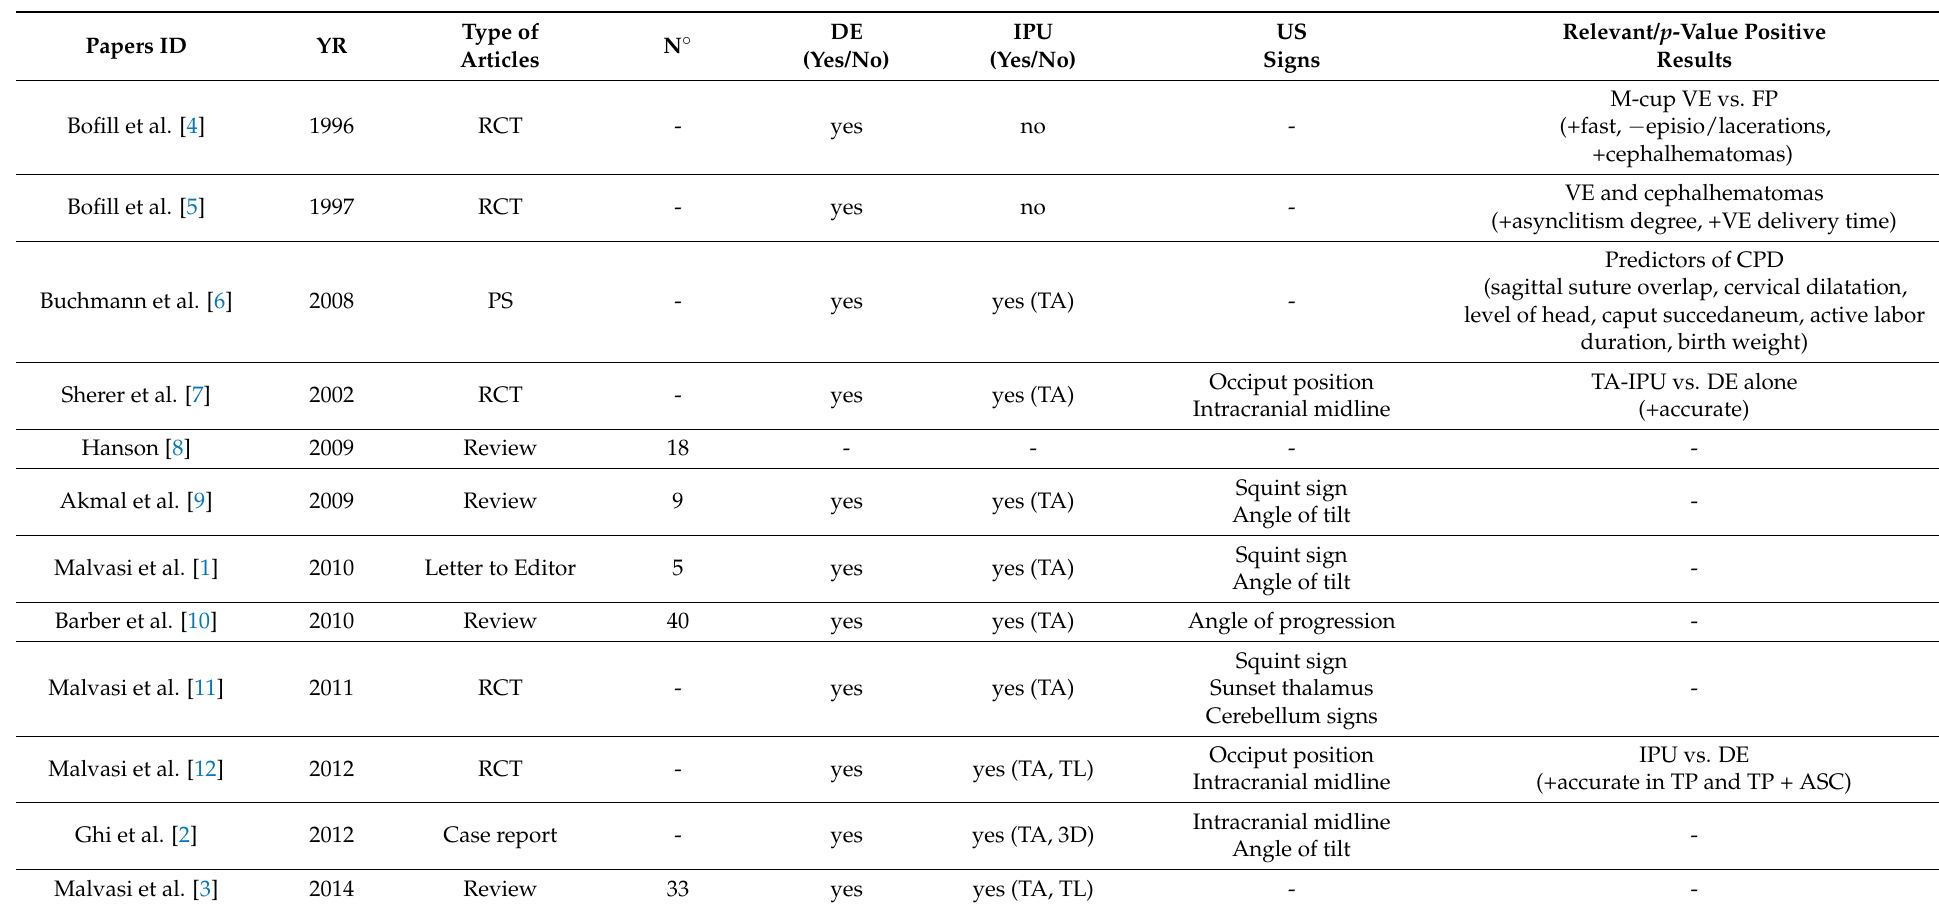
Table 1. All the articles available in literature in the last 30 years on asynclitism with a short description of their main characteristics and relevant results. Abbreviations: 4CW, four-chamber view; AoP, angle of progression; ASC, asynclitism; CPD, cephalopelvic disproportion; CS, cesarean section; DE, digital